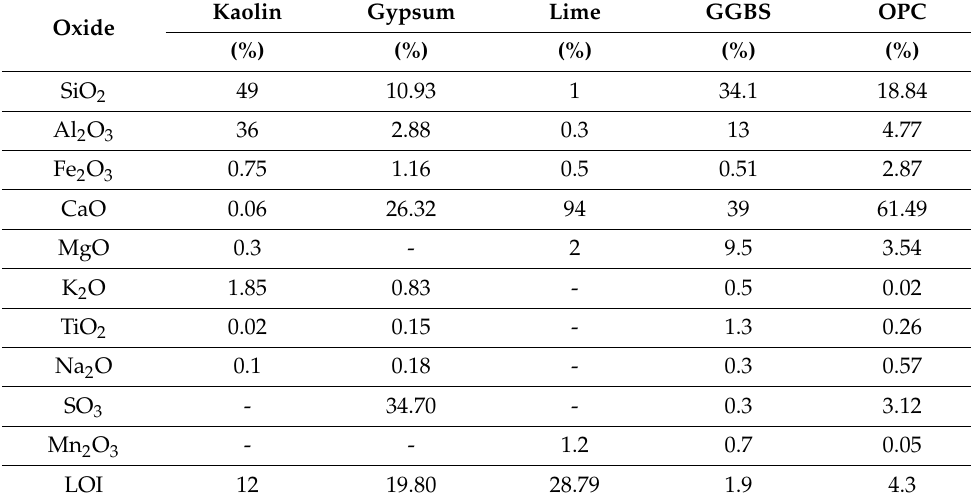
Table 1. Chemical composition of materials.